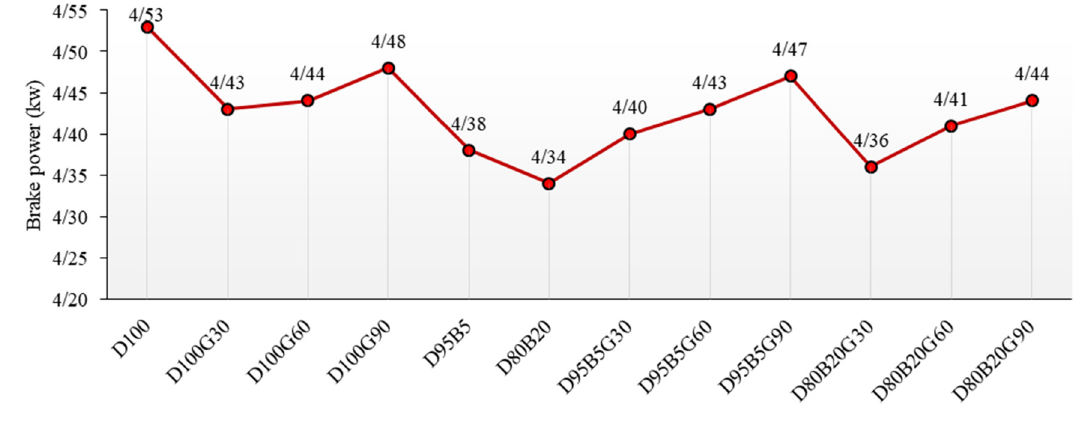
Figure 3: Variations in the BP for di ff erent fuel blends.